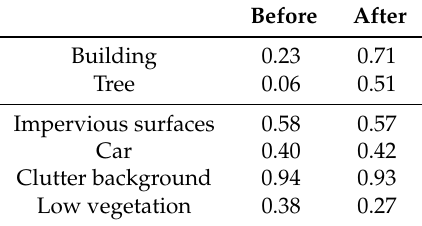
Table 4. Accuracy of the segmentation on every class before and after implementation of our algorithm. Before After